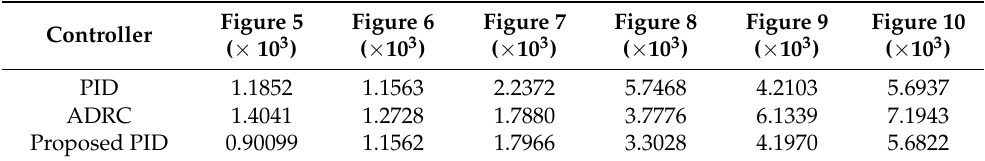
Table 2. IAE of different controllers under different operating conditions.